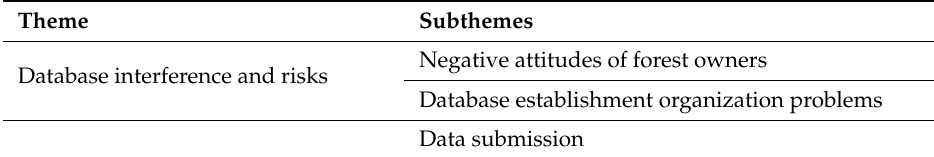
Table 3. Possible interference of the